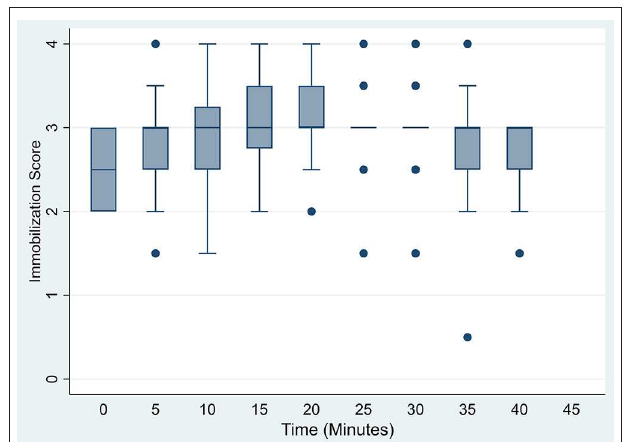
FIGURE 1 | Box plots of immobilization scores for warthogs (Phacochoerus africanus) immobilized with etorphine, azaperone, and butorphanol evaluated at 5min intervals. Horizontal bars represent median values with brackets indicating 95% confidence